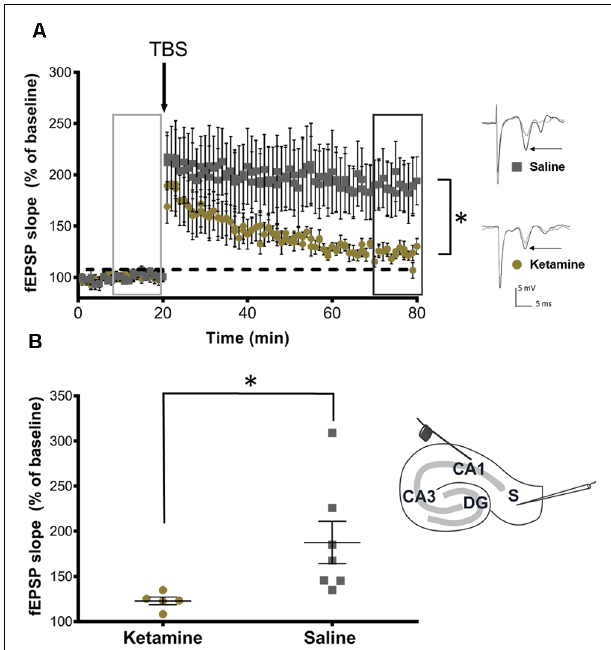
FIGURE 5 | Neonatal ketamine exposure impairs synaptic plasticity in adolescent rats. (A) Time plots of fEPSP slope from CA1 to Subiculum pathway in P28 rats exposed to neonatal saline and ketamine. Theta burst stimulation (TBS) arrow indicates the timing of theta-burst stimulation (40 pulses, 100 Hz). Insets indicate sample traces of fEPSPs before (light gray trace) and after (dark gray trace) TBS stimulation in saline and ketamine treated groups. Inset arrows indicate representative trace components used in analyses. (B) Quantification of change in fEPSP slope after 60 min following TBS (dark gray box) normalized to baseline (light gray box) in ipsilateral slices and contralateral slices, set at 100%. Rats exposed to neonatal ketamine showed significant impairment in LTP ( P = 0.032). Each point represents a hippocampal slice (experiment) that was recorded with no more than two experiments per animal used. Inset depicting stimulating electrode placement in stratum oriens at the edge of the CA1 and recording electrode in stratum-radiatum subicular neurons, ∗ P <